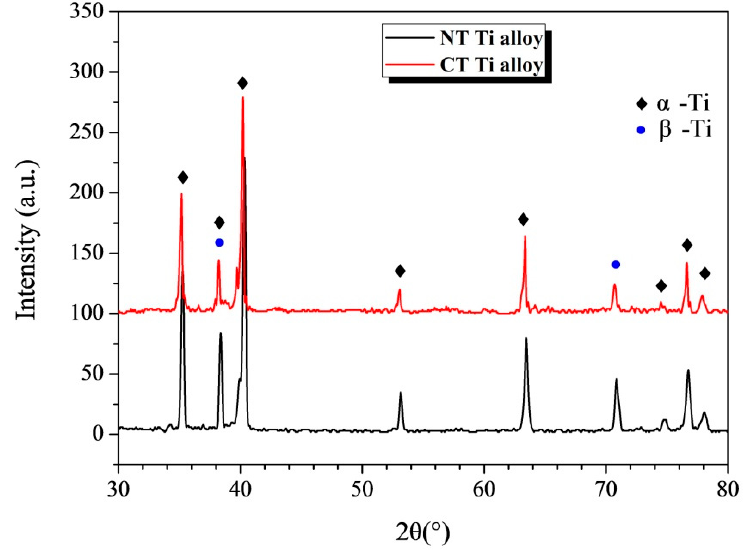
Figure 2. The X-ray diffraction (XRD) patterns of Ti-6Al-4V alloy with and without cryogenic treatment.